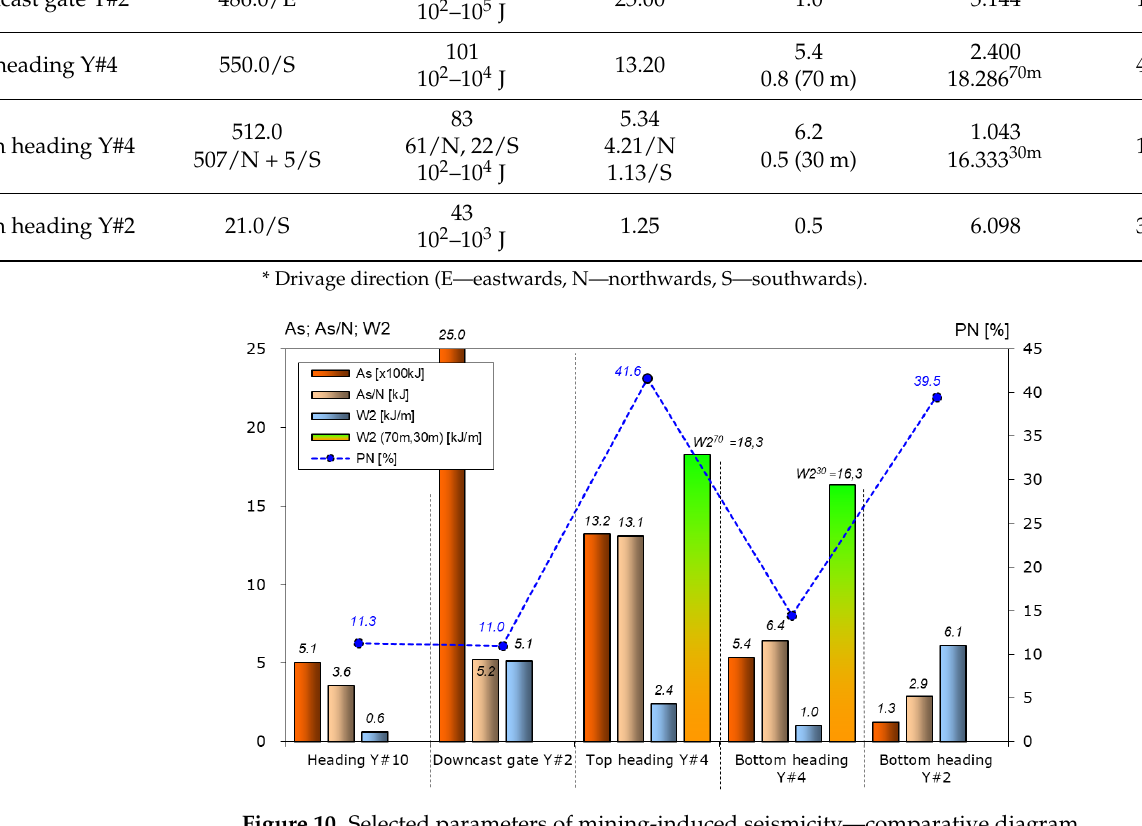
Figure 10. Selected parameters of mining-induced seismicity — comparative diagram.